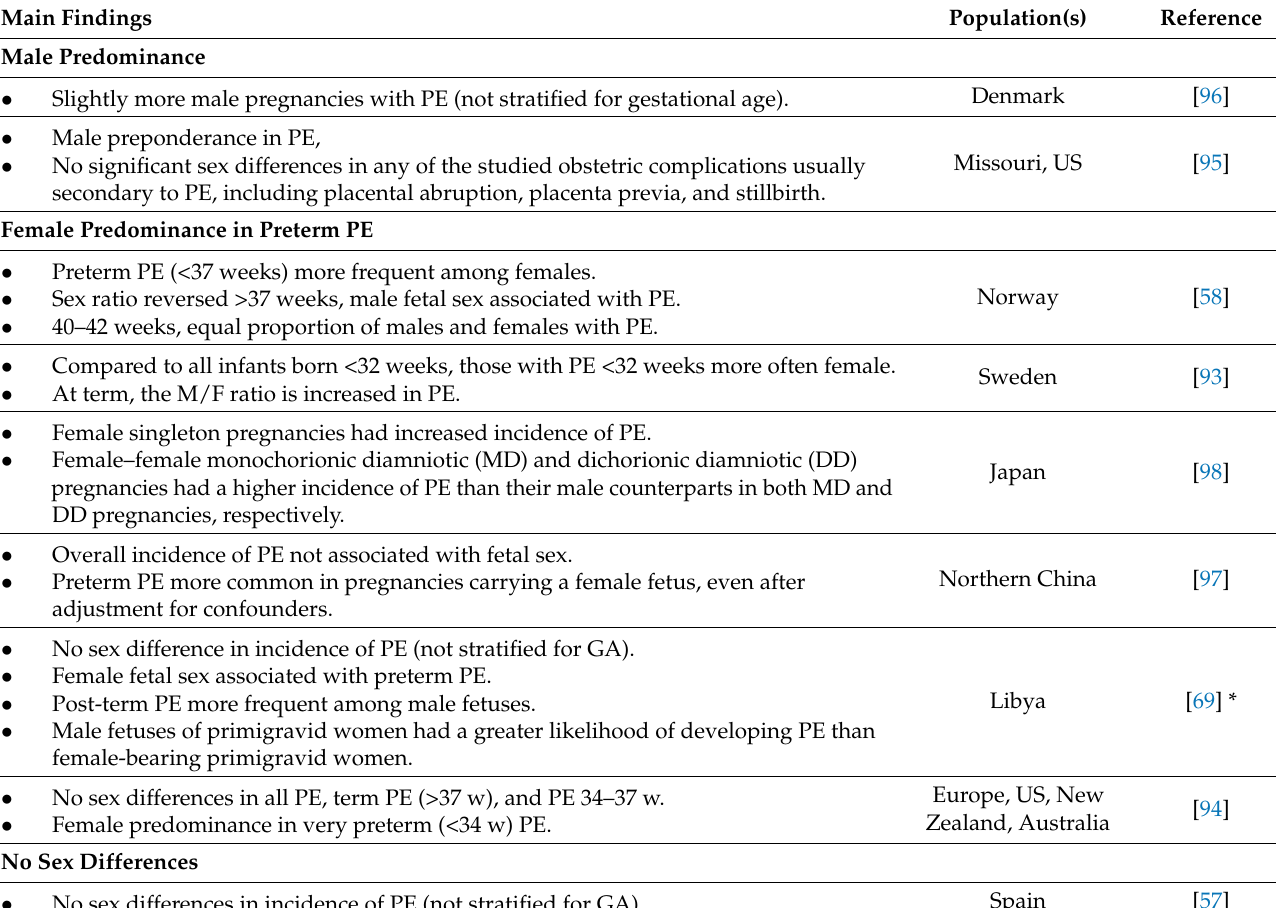
Table 3. Summary of findings from preeclampsia (PE) studies. An asterisk indicates n PE < 1000. Main